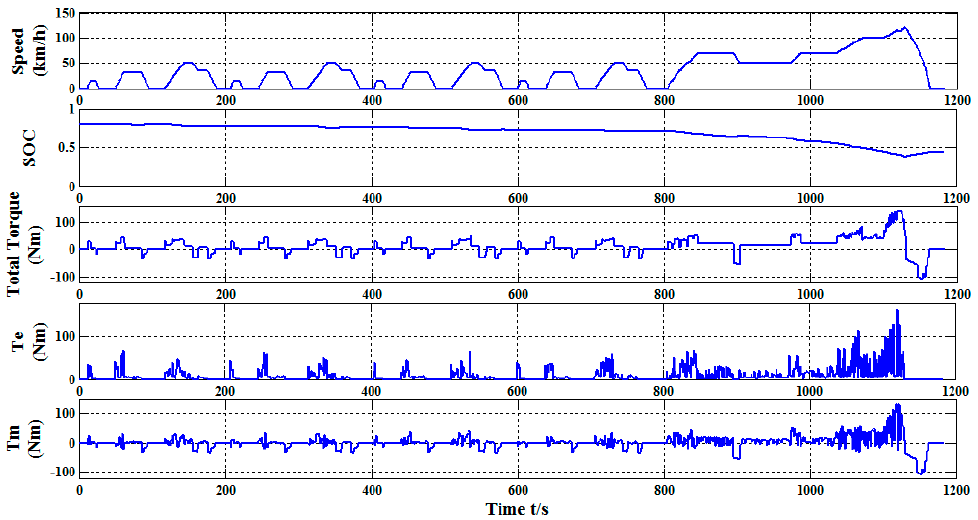
Figure 11. Simulation results under NEDC of the online trained EMS which was pre-trained under UDDS. Table 6. Comparison of the results under NEDC.